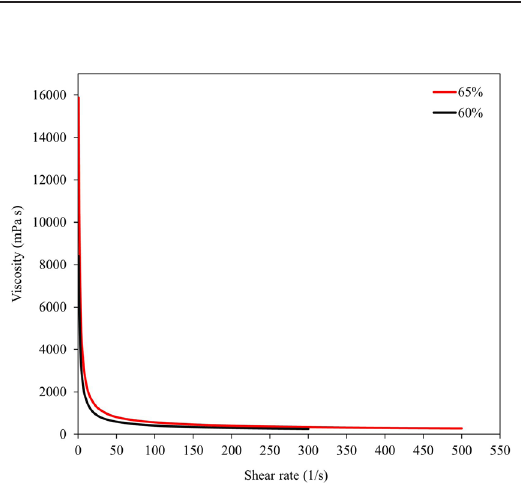
Figure 12. Viscosity curves for the 65/1 and 60/1 composition slurries obtained after homogenization in vibrating mill for 20 min.